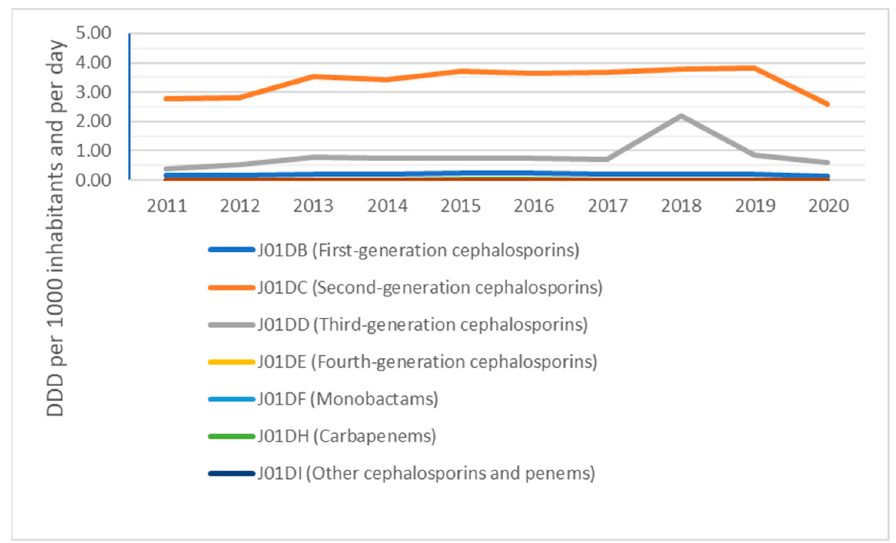
Figure 3. Other beta-lactam antibacterials (ATC group J01D) in the community.